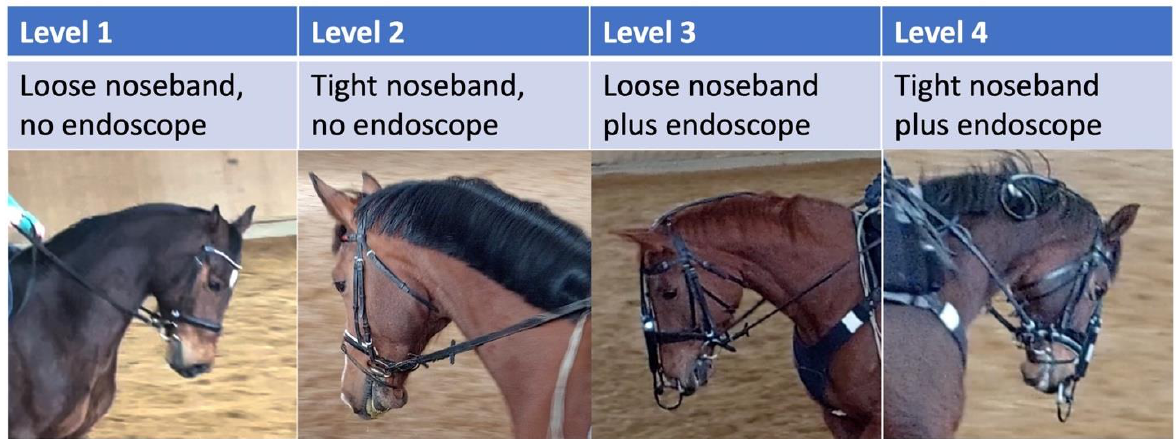
Figure 1. The four levels of stress induction used in this study.